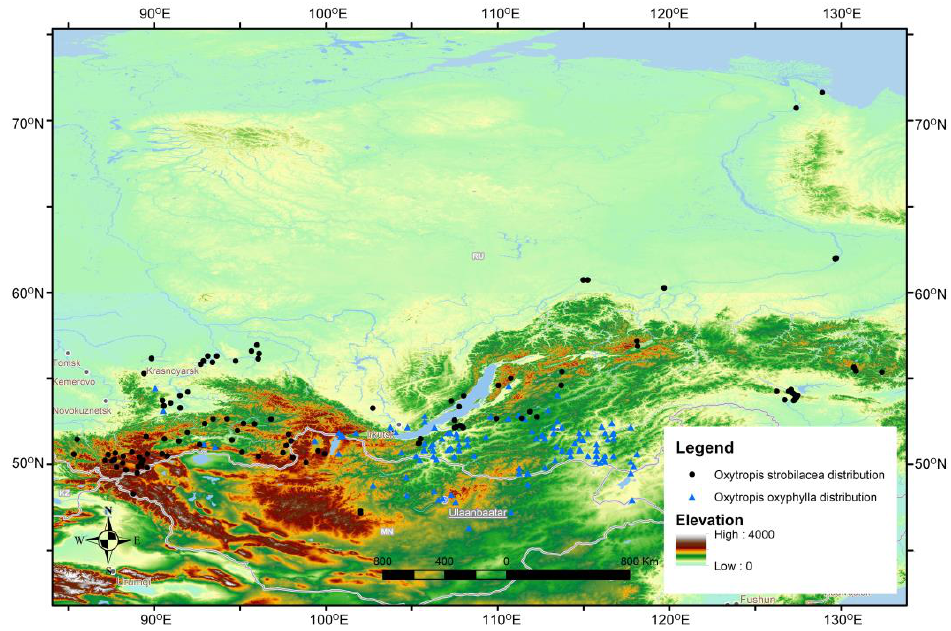
Figure 5. Distribution of Oxytropis strobilacea and Oxytropis oxyphylla .